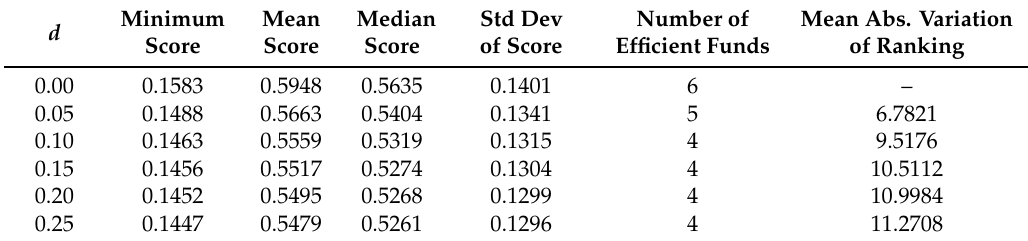
Table 7. Main results for the VW restrictions with constraints only on the target DMU in the case of symmetric bounds and T = 7. Summary statistics on the performance scores (minimum, mean and median values, standard deviation), number of efficient funds and mean absolute variation (divided by 2) of the ranking